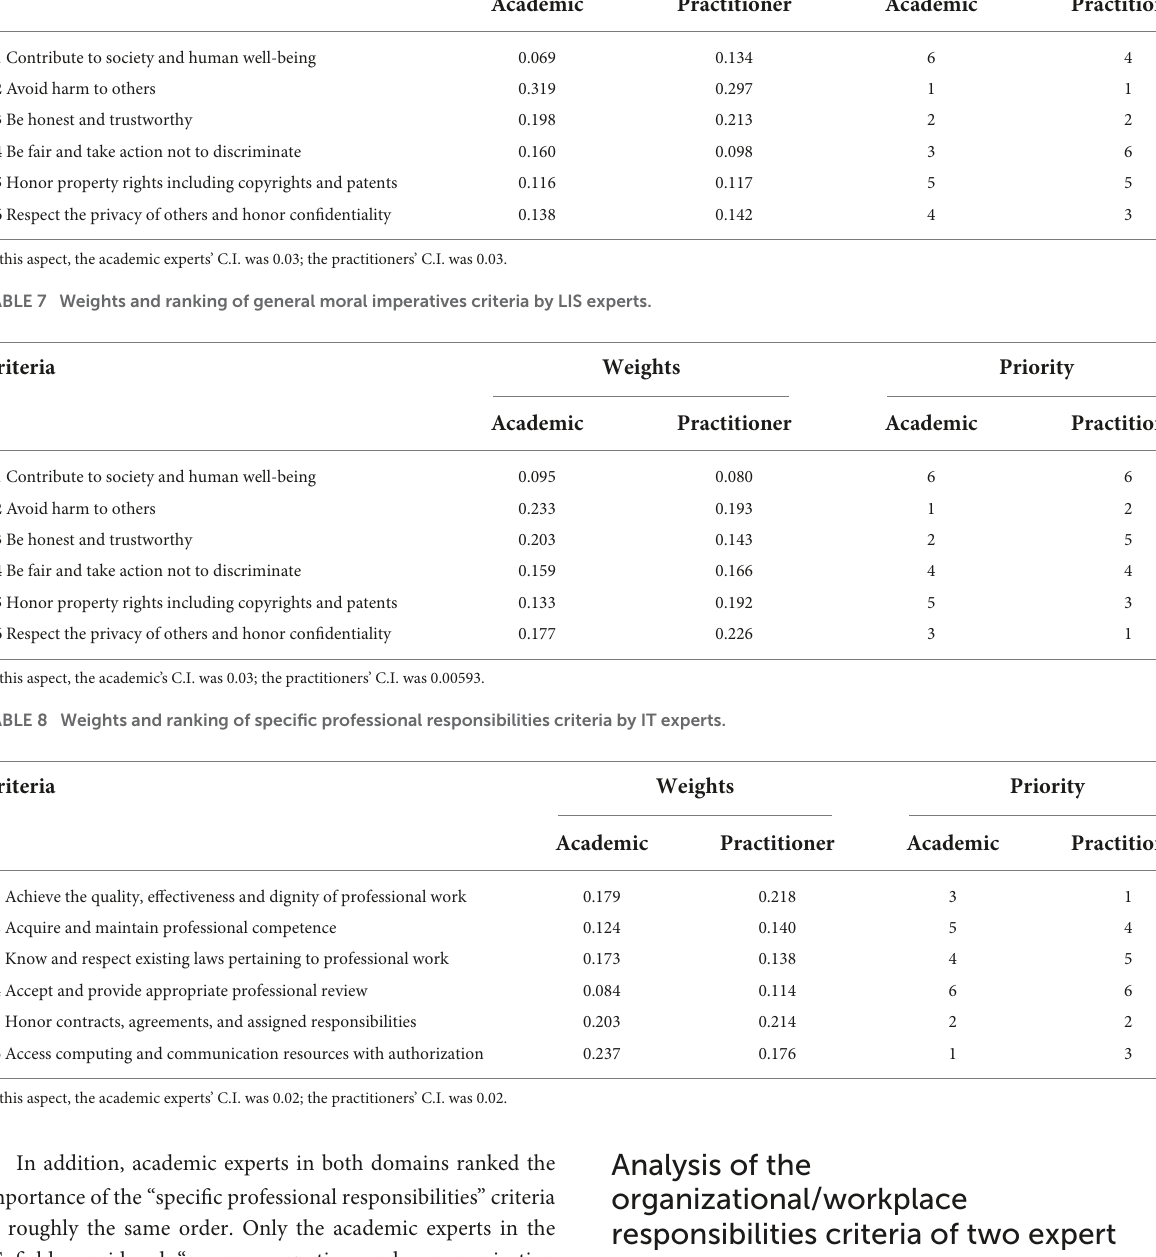
TABLE 6 Weights and ranking of general moral imperatives criteria by IT experts.